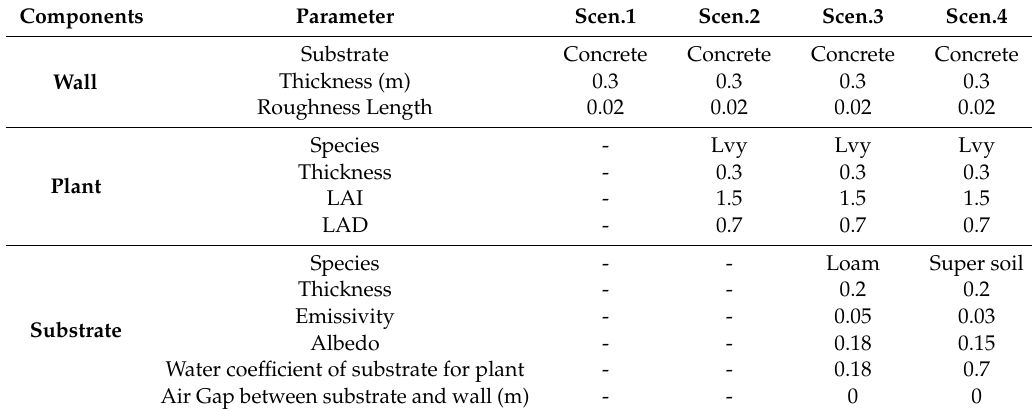
Table 1. Parameters of four facade green walls.